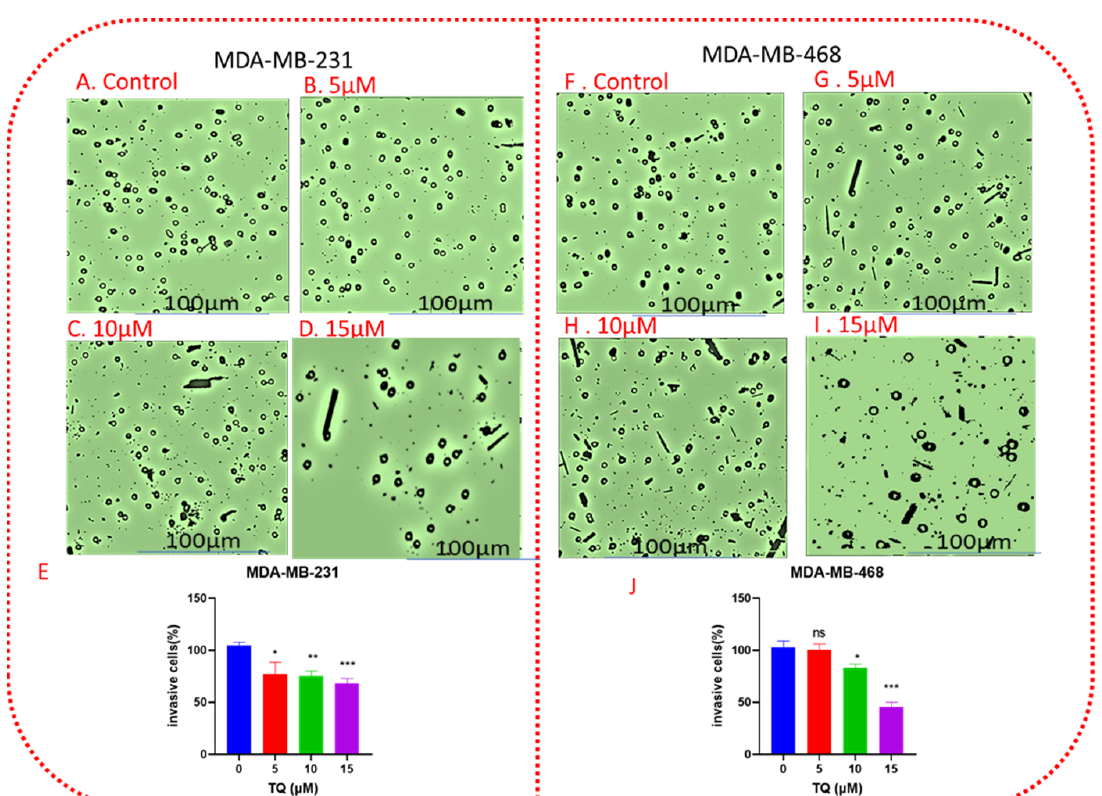
Figure 6. TQ inhibits TNBC cell invasion. A monolayer of TNBC MDA-MB-231 cells and MDA-MB- 468 were treated with DMSO (control), 5, 10, and 15 µ M for 24 h. Images ( A – D , F – I ) showed the relative invaded cells to the membrane for MDA-MB-231 and MDA-MB-468 cells, respectively, in a concentration dependent manner. Bar graphs ( E , J ) show the percentage of invaded cells per insert for the corresponding cell lines. The means ± SEMs of three independent experiments, each performed in triplicates, were analyzed by Student’s t -test. * p < 0.05, ** p < 0.01, *** p < 0.001; ns, nonsignificant. All scale bars indicate 100 µm in 10× magnification.